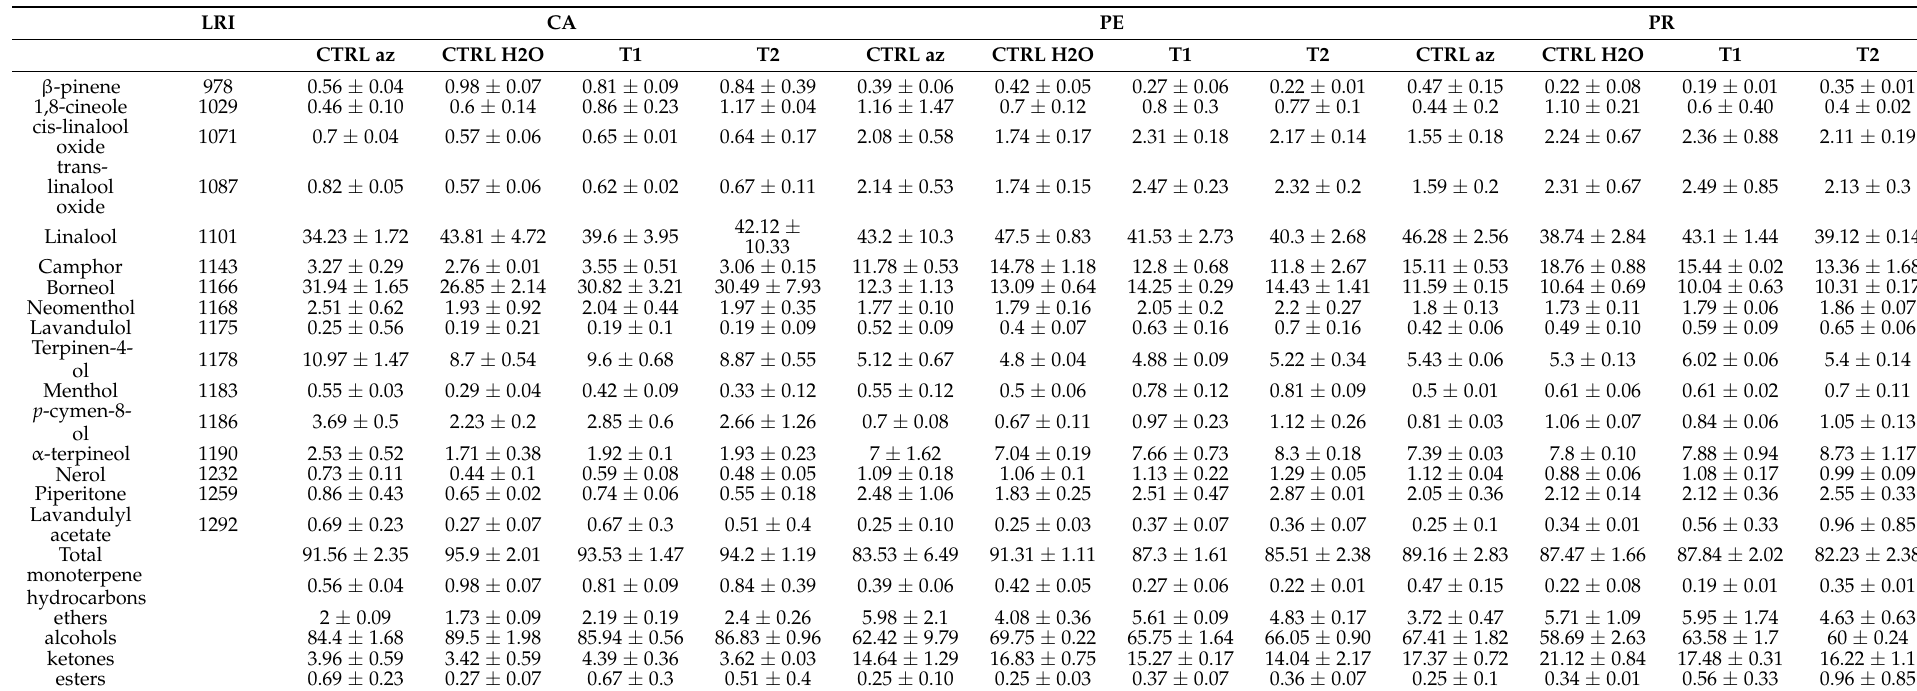
Table 3. Hydrosol terpene % composition of all the samples expressed as mean ± standard